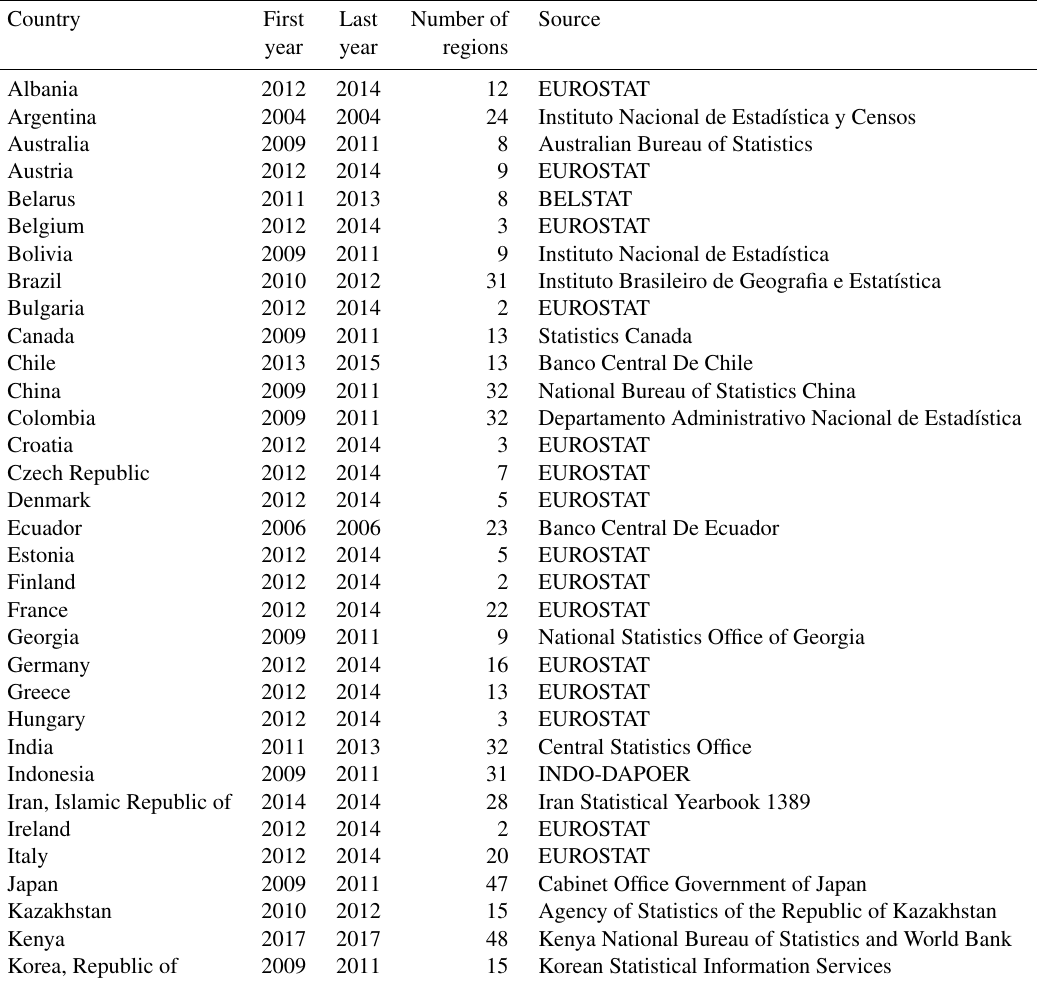
Table B7. Regional accounts descriptive